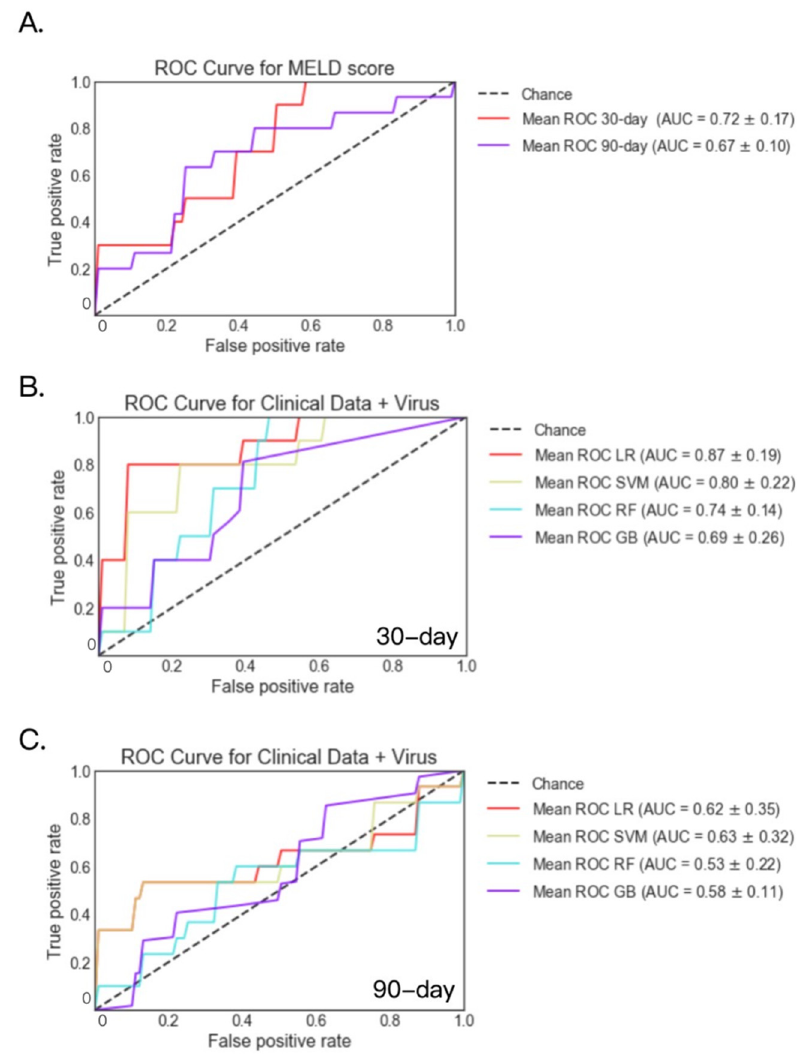
Figure 5. 30- and 90-day mortality prediction using fecal viruses and clinical data in patients with alcoholic hepatitis. ( A ) 30- and 90-day mortality prediction using MELD score. ( B ) 30-day mortality prediction using fecal viruses and clinical data. Deceased group n = 8; alive group n = 68. ( C ) 90-day mortality prediction using fecal viruses and clinical data. Deceased group n = 14; alive group n = 42.